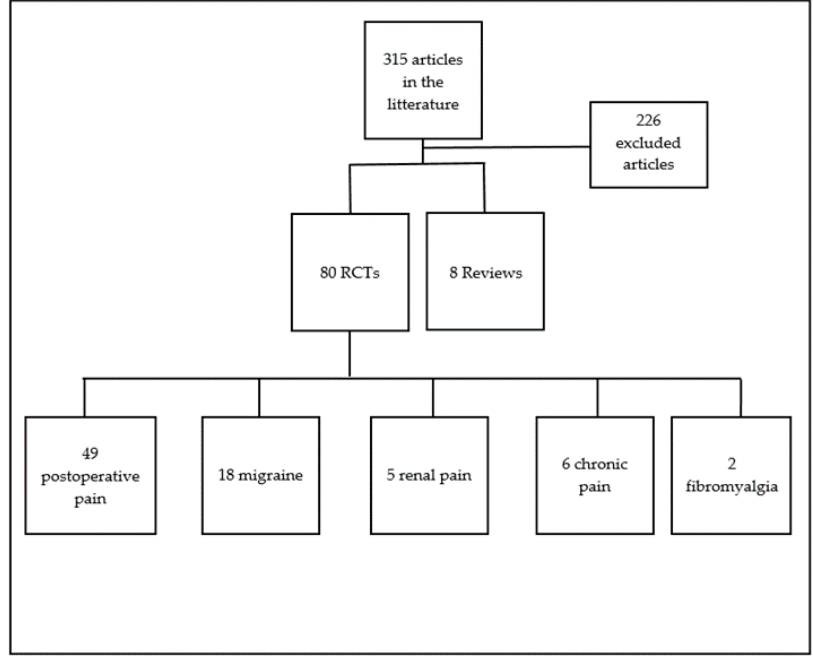
Figure 1. Flow chart of articles on magnesium, pain and analgesics consumption.